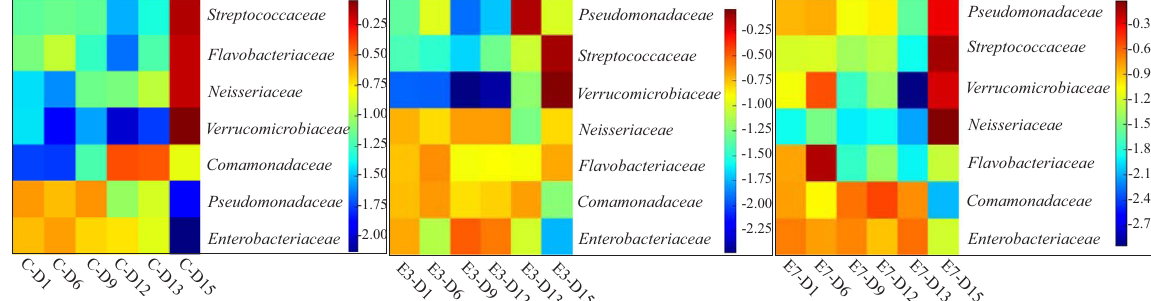
Figure 4. Heat map of functional bacterial families in serially passaged control bioreactor and electro- bioreactors E3 and E7. It was observed that microbial subpopulations associated with sludge bulking and foaming are different in electro-bioreactors when compared to control bioreactor. (C-Di: Control sample in day i; E-Dj: Electro-bioreactor sample in day j).